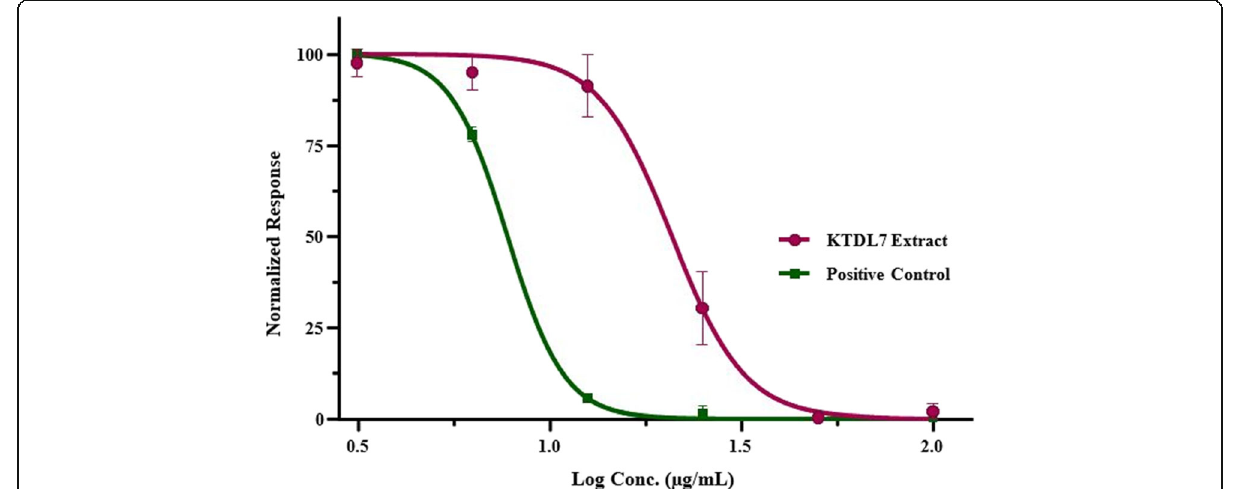
Fig. 2 Dose-response inhibition curve of the crude extract of Alternaria sp. KTDL7 on UMG87 glioblastoma